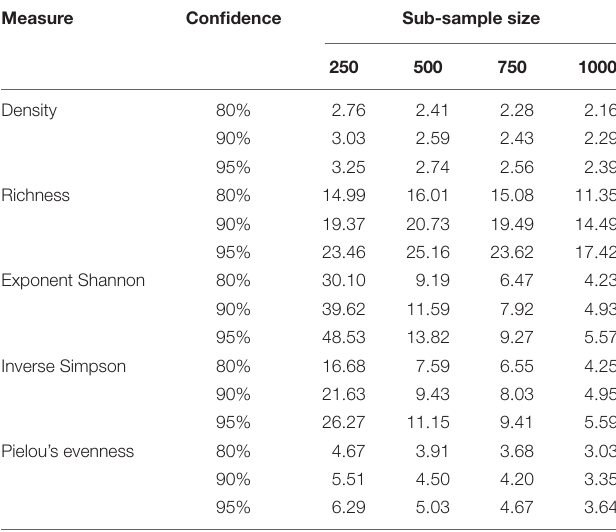
TABLE 4 | Number of monitoring sites required to detect the (25n + 26a) treatment as compared to the baseline. Measure Confidence